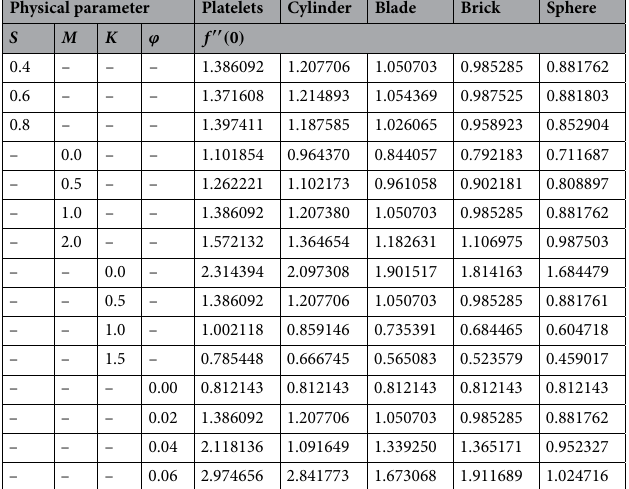
Table 4. The numerical results Nusselt number